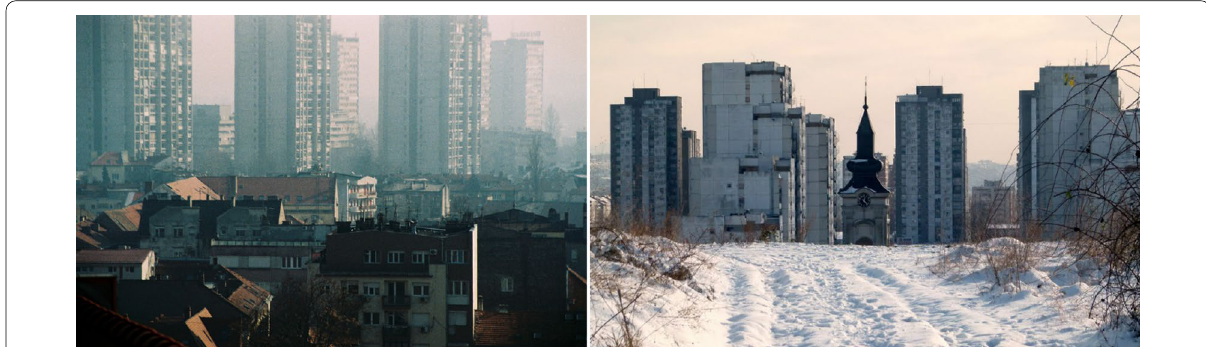
Fig. 2 Two illustrations of layered singularities on the example of Belgrade city. Photos by Jelena